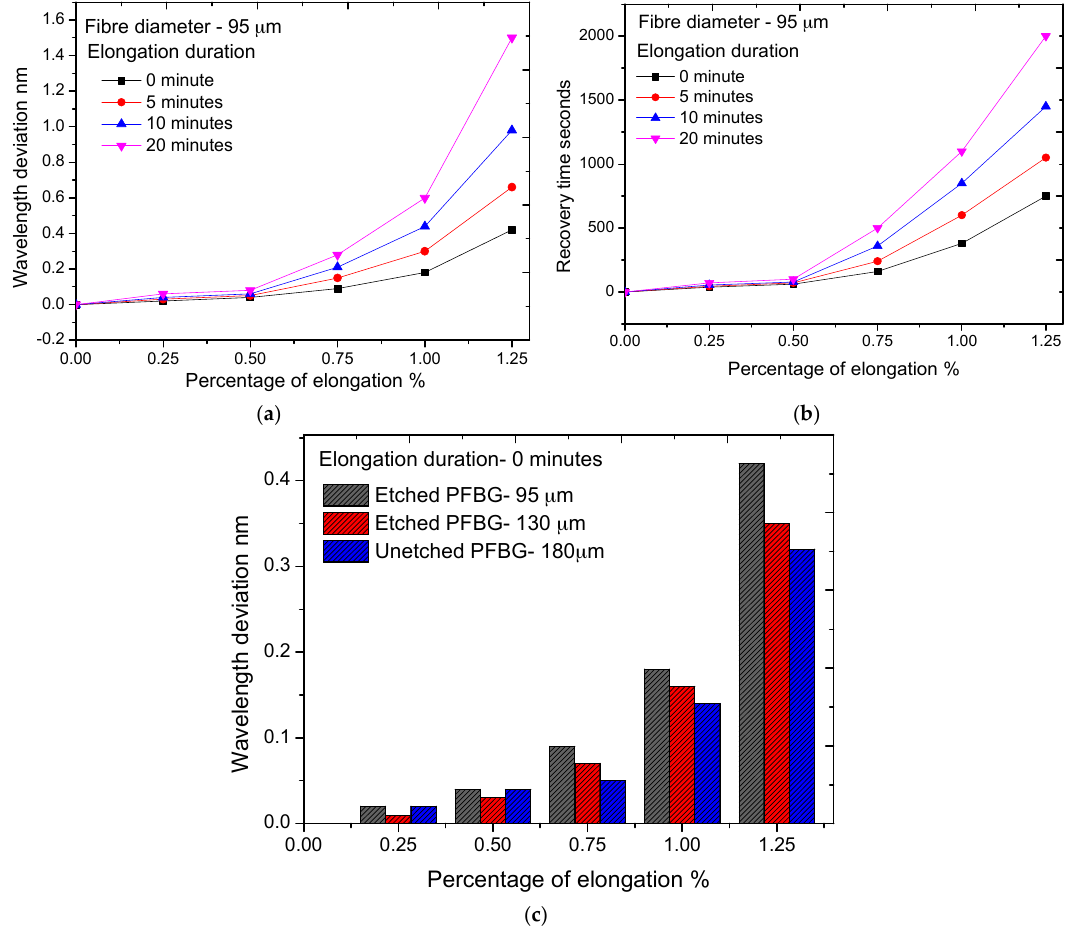
Figure 7. Effect of hysteresis on etched PFBGs for different elongations and time duration. ( a ) Measured wavelength deviation; ( b ) recovery time; ( c ) wavelength deviation of PFBG with different diameters.